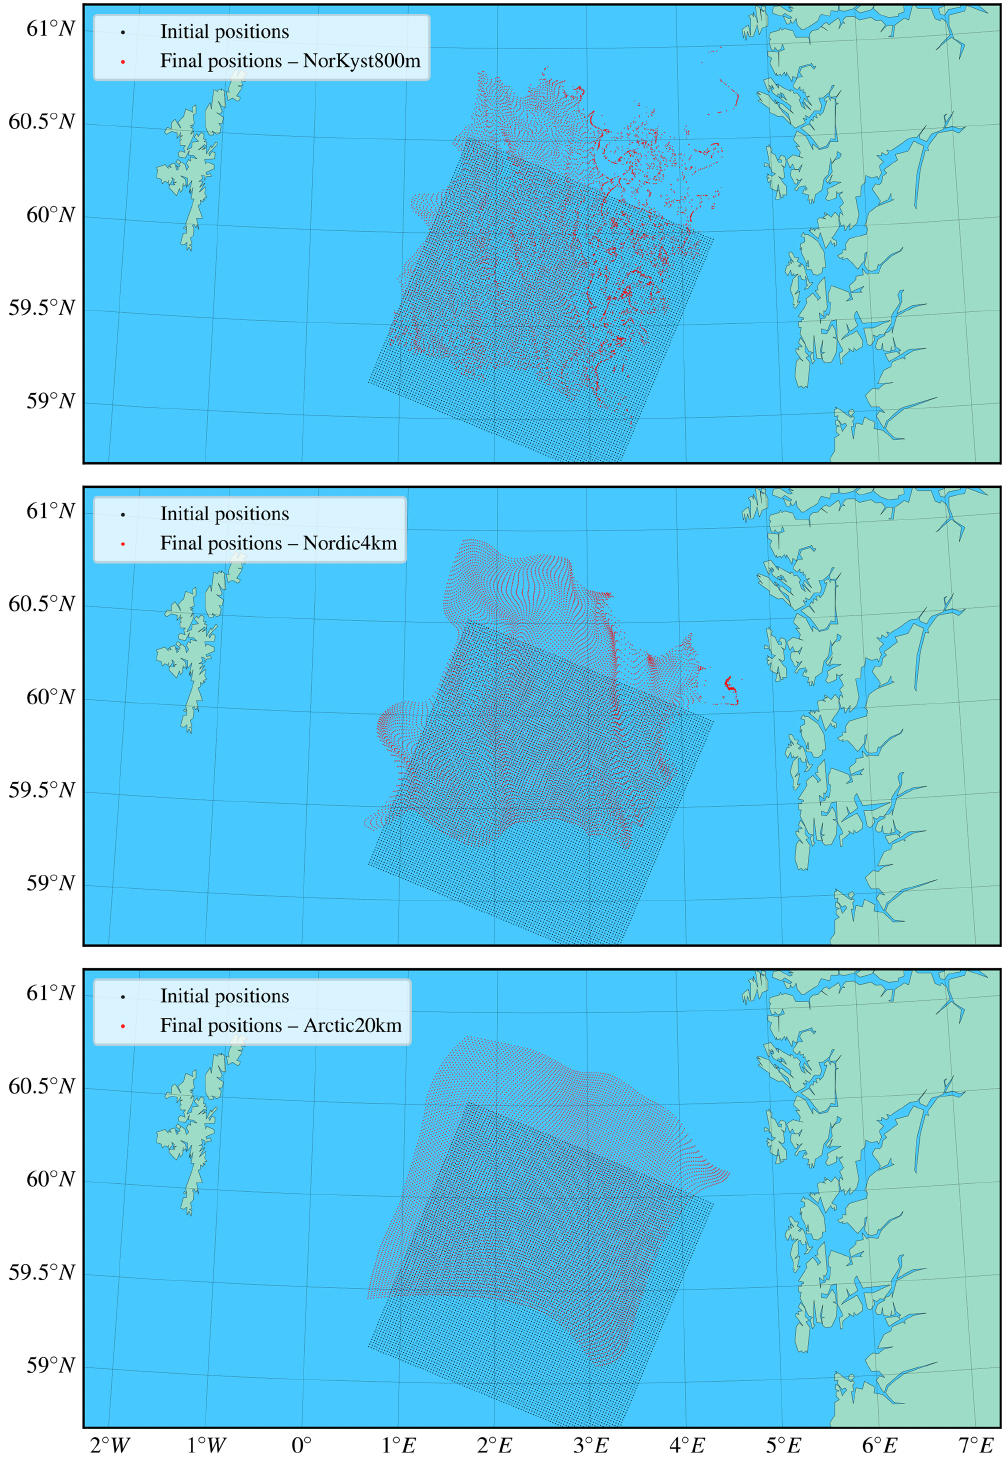
Figure 4. The figure shows the initial and final positions of the 10000 particles for the three different datasets. The initial positions are the same, but the final positions differ. The average transport is towards the north in all cases, but the higher-resolution currents show more eddy activity, particularly in the eastern region, which falls within the Norwegian Coastal Current (see, e.g. Sætre, 2005). These plots show the positions calculated with cubic interpolation, fourth-order Runge–Kutta, and a time step of 1s. Results obtained with the other methods appear visually identical at this